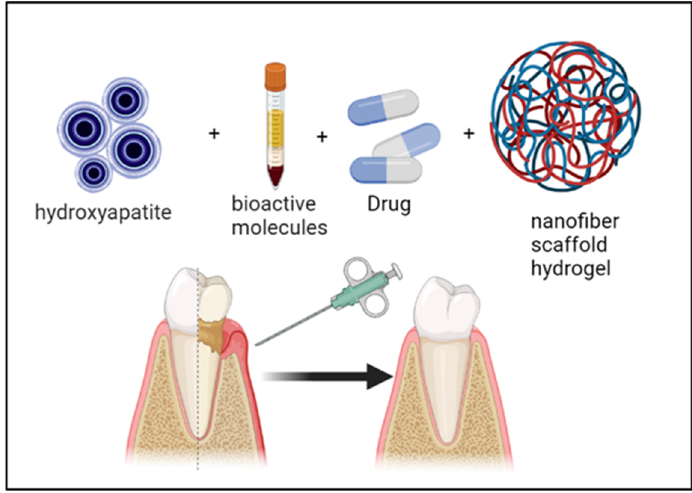
Figure 1. Hydrogel-based scaffolds for periodontal regeneration.